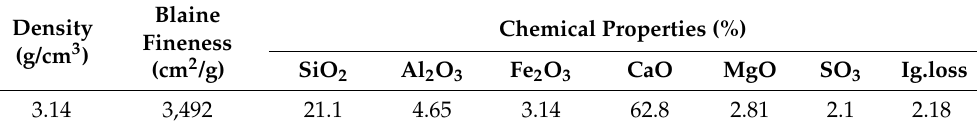
Table 2. Physical and Chemical properties of OPC.